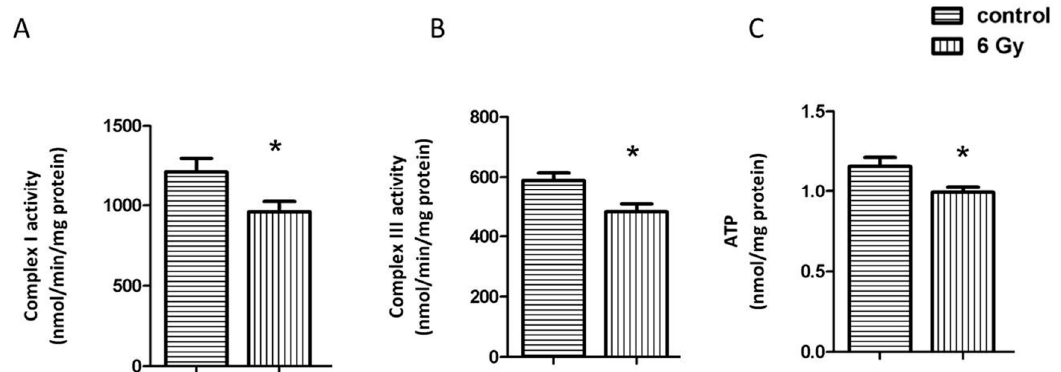
Figure 3. Analysis of the mitochondrial complex I and II activity, and cardiac ATP level. The activities of complex I and III were compared in irradiated and control samples ( A and B ). The ATP levels were compared in irradiated and control samples ( C ). The error bars represent standard error of the mean (± SEM) (t-test; * p < 0.05; n = 4).